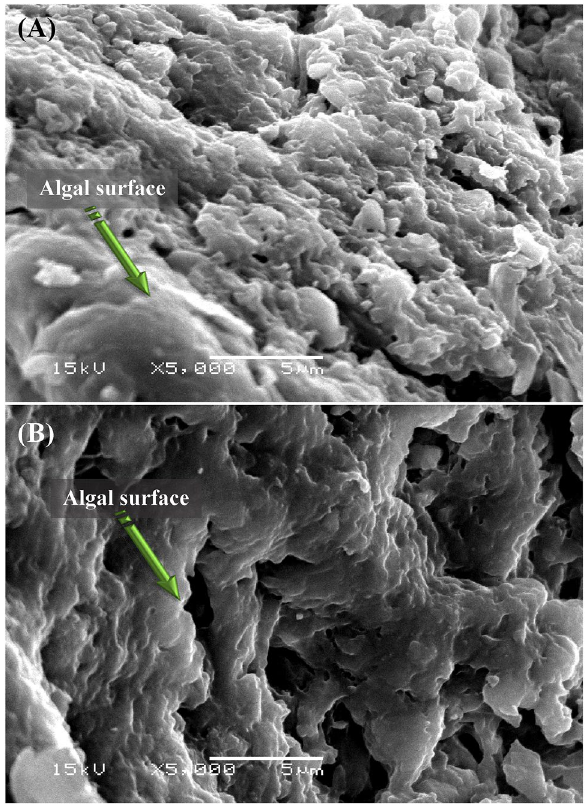
Figure 8. SEM micrograph of Scenedesmus obliquus biomass: ( A ) before and ( B ) after methyl red of the dye elevating the available nitrogen to alga. When the nitrogen deficiency reached day 10, the lipid content of Scenedesmus sp. increased from 14 to 31% 83 . Numerous other hydrocarbons were detected in addition to fatty acids due to the algae’s metabolism being distinct from that of phototrophic algae. The microgreen algae Chlorella pyrenoidosa and Chlorella vulagris degrade dyes into simple aromatic amines and decolorize dye wastewater 84 . Therefore, it is possible to use the fatty acids extracted from alga grown with methyl red to produce biodiesel and simultaneously remove dyes. An engine fuelled with biodiesel containing superior oxygen content can lead to lower CO emissions with increasing blend ratio due to complete combustion in the diesel engine. An engine fuelled with biodiesel con- taining superior cetane number and higher lubricity is more effective. Biodiesel with higher gross calorific value produces higher power. Biodiesel has a higher viscosity, which causes fuel flow and ignition problems in engines and decreases power output 85 . Lipid yields by microalgae are controlled by various culturing conditions, such as nitrogen deprivation 86 , harvesting times 87 , and pH 88 . Addi- tionally, the methods and solvents used to extract lipids affect lipid yields and contents 43 . The oxidation state of the nitrogen source (i.e., NH 4 or NO 3 ) can promote the influence of biomass yield 89 . Musa et al. 90 reported that the use of NO 3 as a nitrogen source requires high energy and diminishes biomass yield. The results indicated that unsaturated fatty acids were more abundant than saturated fatty acids. Saturated acid components in algal bio- mass are in the range of 25–45%, while unsaturated fatty acid contents account for 50–55% of total fatty acids 91 . Xin et al. 83 reported the potential production of biodiesel from lipids extracted from Scenedesmus sp. grown in wastewater treatment. Mata et al. 92 stated the possible production of biodiesel from Scenedesmus obliquus that was grown in brewery wastewater. The lipid percentage of Scenedesmus obliquus grown with total wastewater was 22.7, whereas the lipid percentage of algae grew in BBM 25.2 51 . Mata et al. 92 reported that Scenedesmus sp. Z-4 displayed great potential to realize simultaneous wastewater treatment and lipid production at low temperatures. Table 6 reported the various factors affecting the decolorization of methyl red dye from aqueous solutions by using different sorbents (algae and bacteria). There was variation in factors (incubation time, pH, methyl red conc., temperature) influencing the decolorization of methyl red according to the biosorbents. The incubation times were 60 h, 20 m, 60 m, 24 h, 48 h and 6 h with the biosorbents Chara vulgaris , Neplhelium lappaceum seeds, Galactomyces geotrichum MTCC 1360, Rhodococcus strain UCC 0016, Bacillus megaterium ITBHU01 and Spirulina -C11; respectively at pH 5, 3, 7, 7.21 and 8 with Chara vulgaris , Neplhelium lappaceum seeds, Rhodococcus strain UCC 0016, Bacillus megaterium ITBHU01 and Aeromonas jandaei strain 93–100 ; respectively. Many studies used algae to remove dyes and heavy metals from wastewater 29,101,102 . The lipid yields by algae can